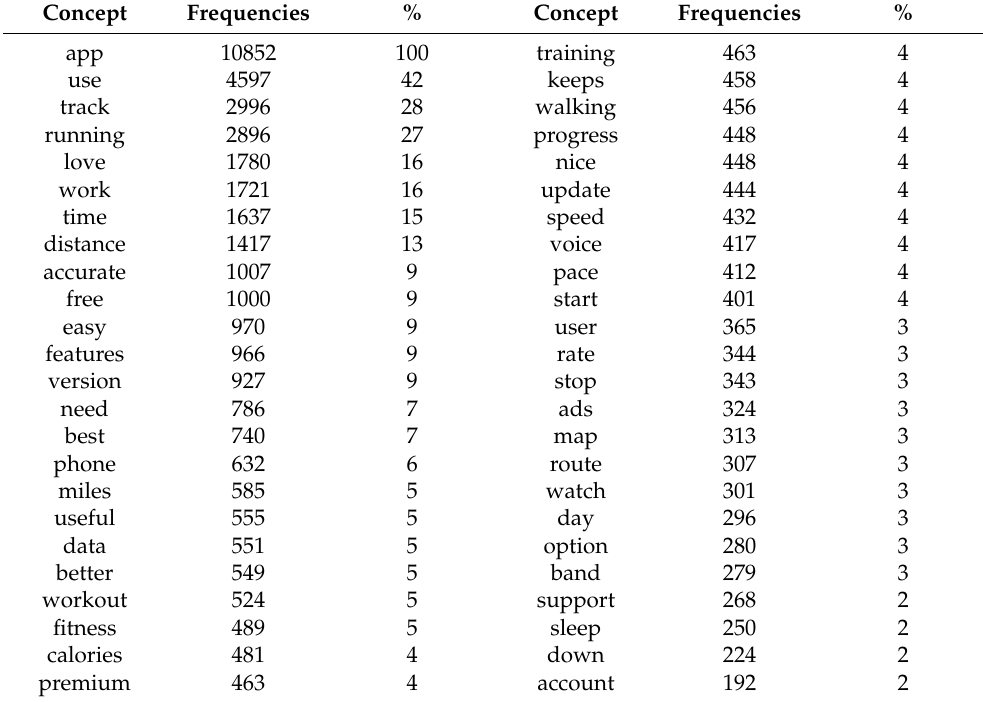
Table 1. Leximancer concept